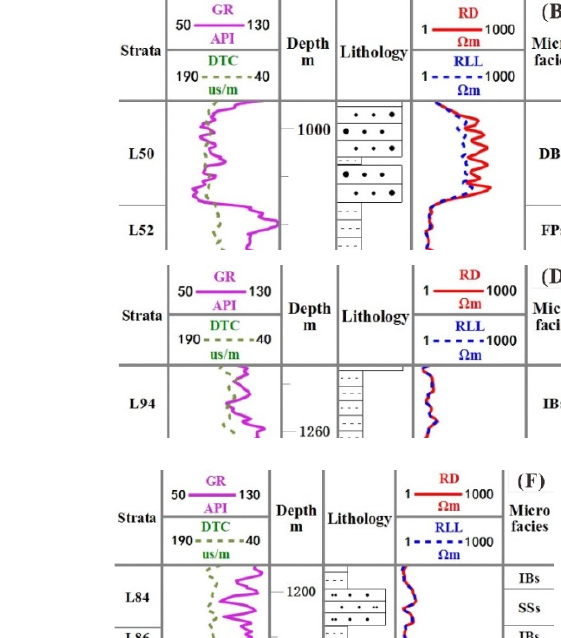
Figure 8. ( A ) PL19 − 3 − F, 1127.8 m, BC, Gray medium sandstone. ( B ) PL19 − 3 − F,1190.4 m, BC, Cross − bedding. ( C ) PL19 − 3 − E, 1190.1 m, DB, Gray fine sandstone. ( D ) PL19 − 3 − F, 1190.43 m, DB, Tabular cross-bedding. ( E ) PL19 − 3 − H, 1157.1 m, DC, Brown pebbly sandstone. ( F ) PL19 − 3 − H, 1158.1 m, DC, Cross − bedding. ( G ) PL19-3-D, 1369.0 m, DC, Erosional basal surface. ( H ) PL19 − 3 − H, 1421.1 m, DC, Erosional basal surface. ( I ) PL19 − 3 − F, 1135.2 m, MB, Gray − black fine sandstone. DC = dis- tributary channel; IB = interdistributary bay; MB = mouth bar; FP = flood plain; SS = sheet sand; BC = braided channel; DB = distributary bar.